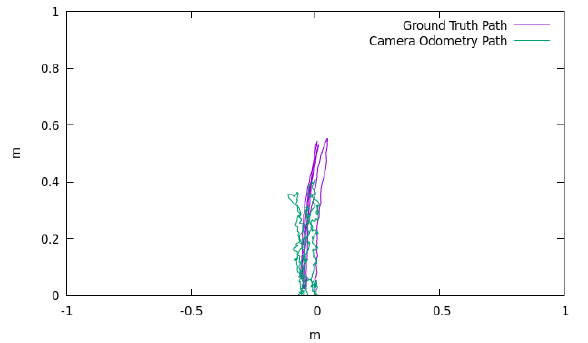
Figure 6. Tracking path for linear movement with non-calibrated camera.